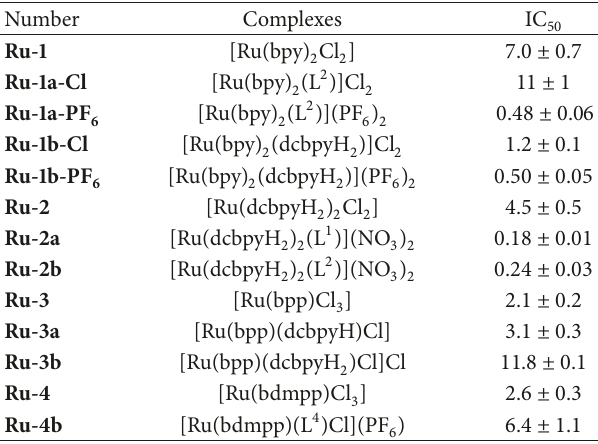
Table 4: IC 50 data ( 𝜇 M) of various Ru(II)/(III) PAF